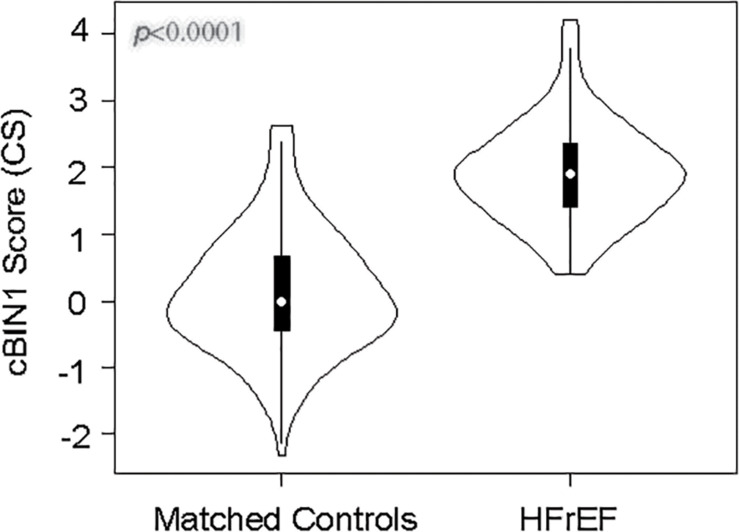
Distribution of CS among HFrEF and matched controls. The vertical axis is the cBIN1 score (CS), and the width of each violin graph depicts the density plot at each measured value. The HFrEF cohort median CS is elevated relative to the controls, 1.9 (IQR 1.4–2.4) compared to 0 (IQR -0.5–0.7), respectively (p < 0.0001).